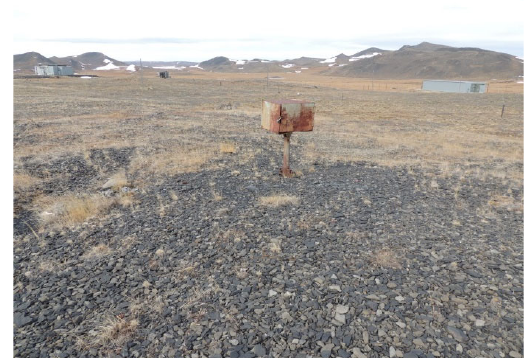
Figure 2. General view of monitoring site 1.